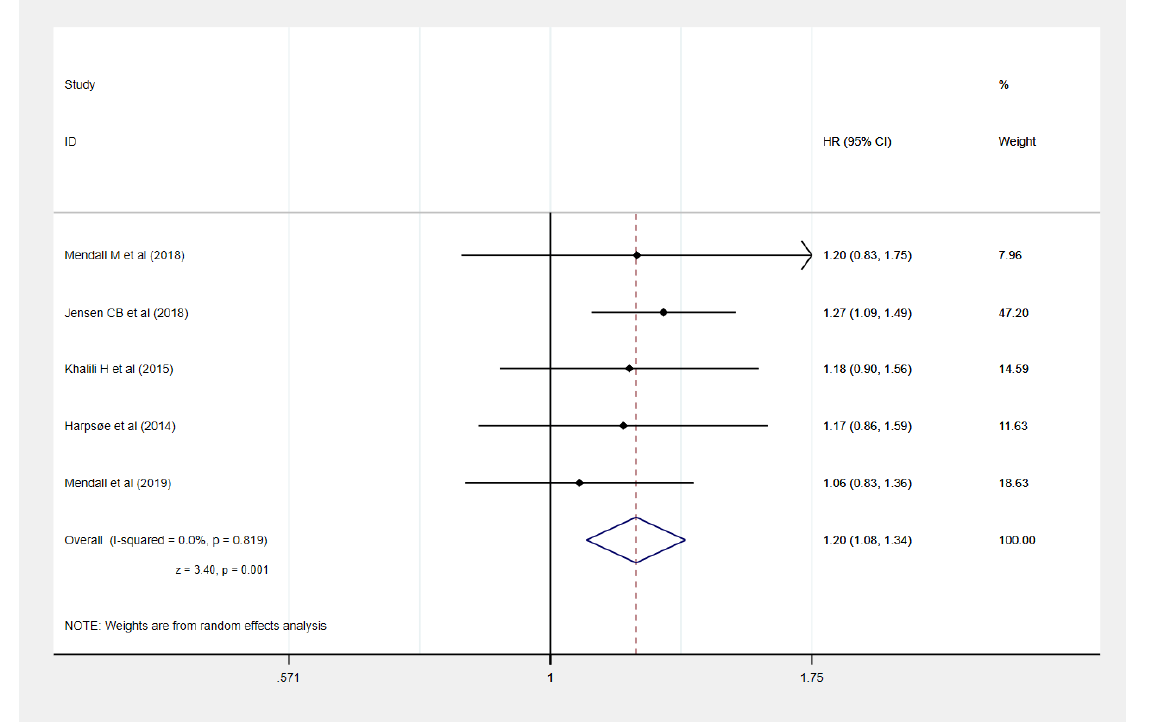
Figure 2. Obesity (body mass index (BMI) ≥30 kg/m 2 ) and development of Inflammatory bowel disease.